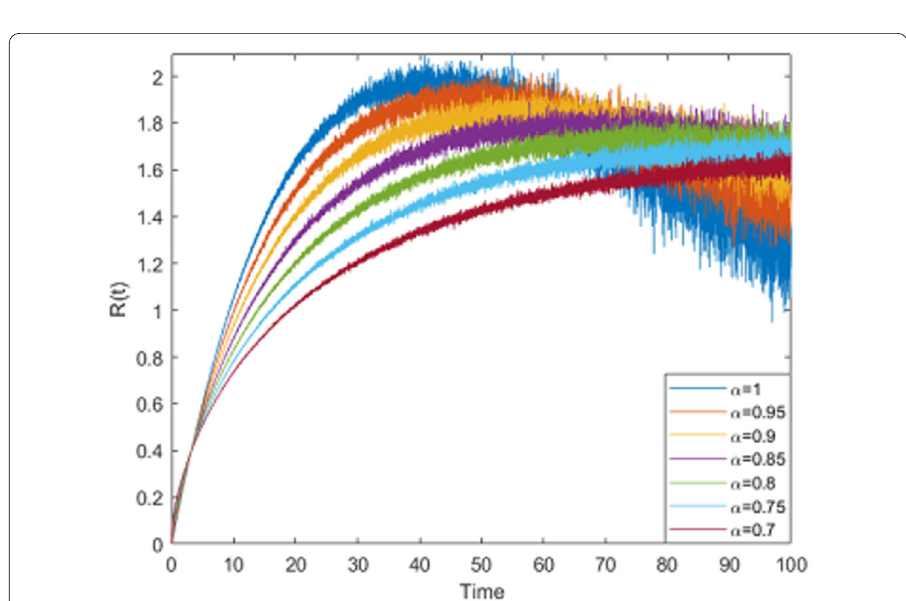
Figure 18 The class of researchers that overcome criticisms for σ 5 = 0.00067